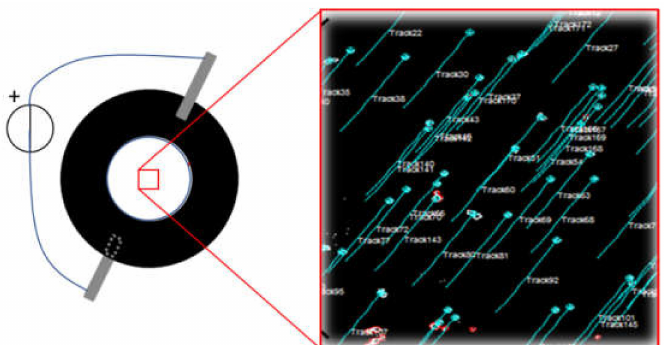
Figure 5. Motion tracks of fluorescent microspheres deposited on the DE film. The image shows the trajectories of single particles as a 4kV voltage step is